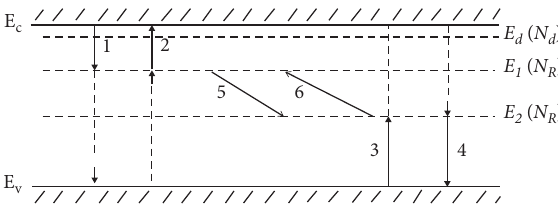
Figure 4: Recombination scheme through a pair recombination complex. Dashed lines show unaccounted